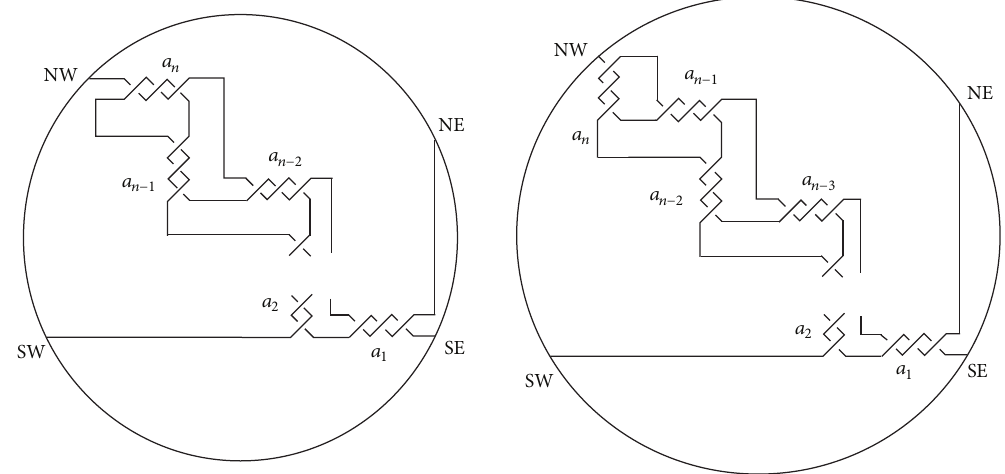
Figure 2: Rational tangles 𝑅(𝑎 1 ,𝑎 2 ,...,𝑎 𝑛 ) for 𝑛 odd or even.